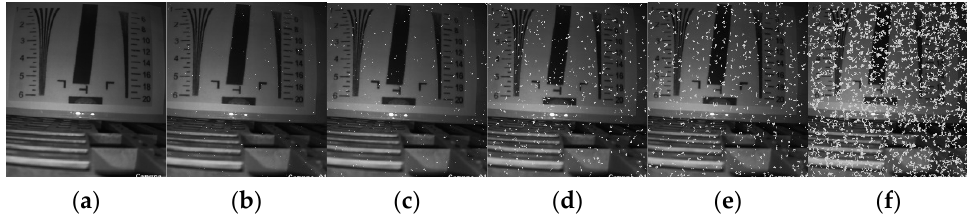
Figure 8. Prediction of irradiation chamber image noise under different accumulated doses: ( a ) Orig-